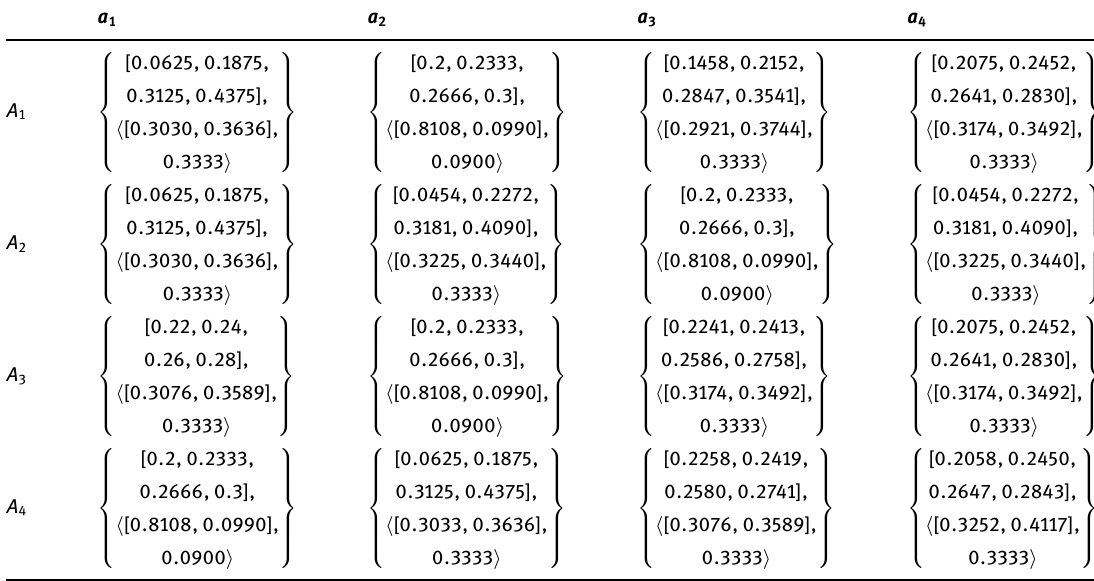
Table 5: Normalized Decision Matrix Given by Expert p 2 .